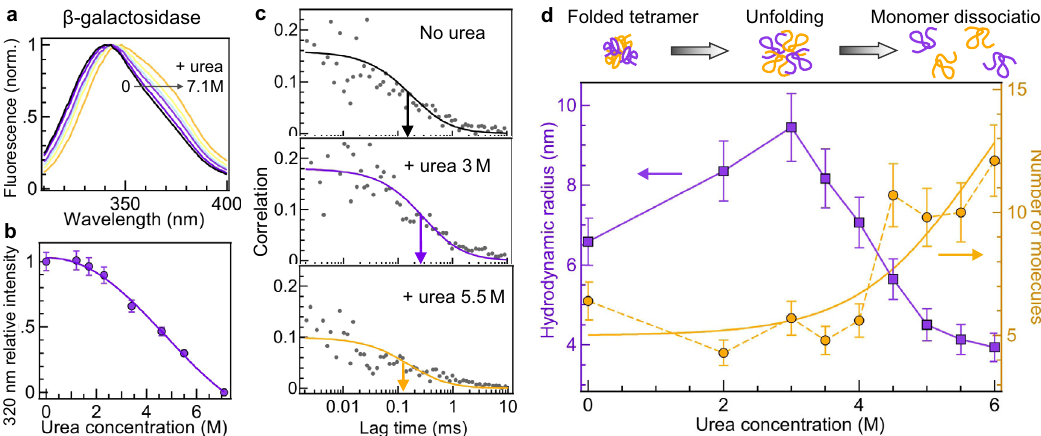
Fig. 4 Application of UV horn antenna to study denaturation of label-free proteins. a Auto fl uorescence spectra of β -galactosidase in presence of increasing concentrations of urea. b Following the approach in 40 , the auto fl uorescence intensity at 320 nm is used to monitor the denaturation of β - galactosidase as a function of the urea concentration. Data are presented as mean values, with the error bars corresponding to a 7% deviation accounting for the measurement uncertainty. The measurements have been repeated twice. c FCS correlation functions of β -galactosidase with increasing urea concentrations. The color lines are numerical fi ts. The arrows indicate the half-width of the correlation. d Evolution of the protein average hydrodynamic radius (left axis) and the mean number of detected molecules (right axis) as a function of the urea concentration. Error bars are standard deviations of the FCS measurements. Each measurement has been reproduced independently at least two times. The yellow line is a guide to the eyes based on a sigmoid function fi t 5 þ 15 = ð 1 þ e 6 (cid:2) c Þ where c is the urea concentration in